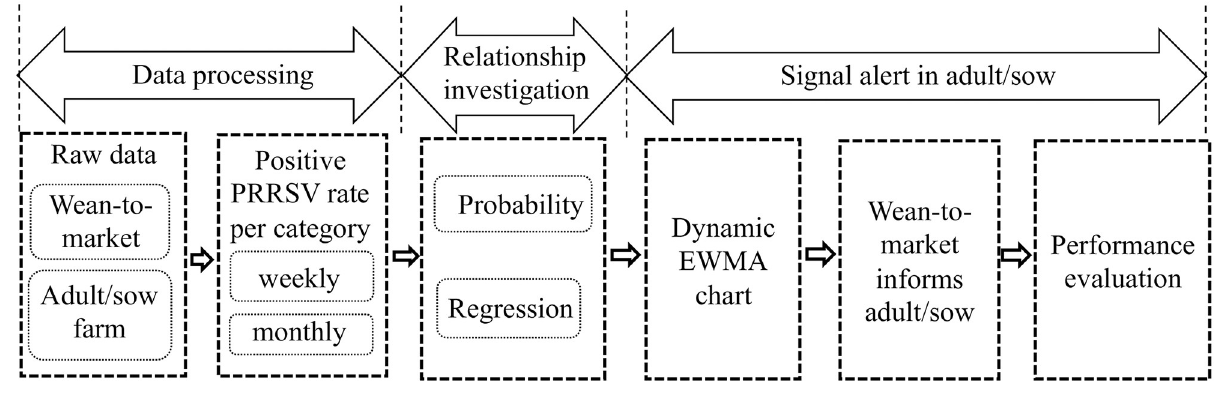
Fig 1. The schematic of the